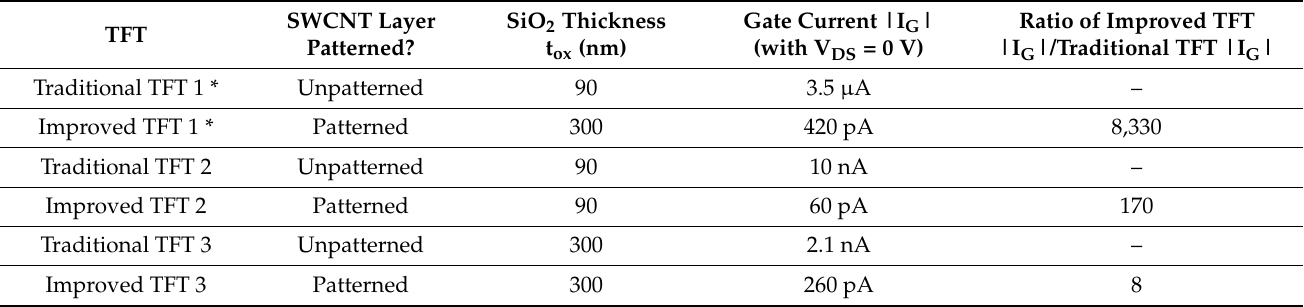
Figure 9. |I G | versus V GS characteristics (with constant V DS ) measured for the: ( a ) traditional (unpatterned) TFT with 90 nm SiO 2 , ( b ) improved (patterned) TFT with 90 nm SiO 2 , ( c ) traditional (unpatterned) TFT with 300 nm SiO 2 , and ( d ) improved (patterned) TFT with 300 nm SiO 2 . Table 4. Comparing the gate currents of traditional and improved